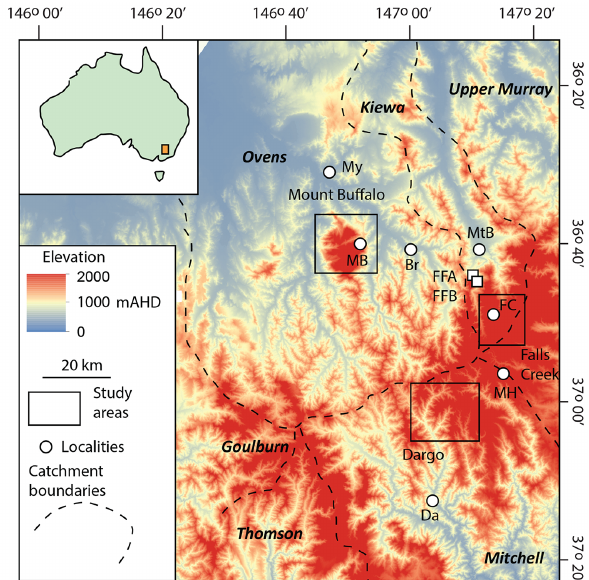
Figure 1. Location of study sites in northeast Victoria superimposed on the digital elevation model. Places: Br indicates Bright; Da indi- cates Dargo; MB indicates Mount Buffalo; MtB indicates Mount Beauty; MH indicates Mount Hotham; My indicates Myrtleford. FFA and FFB are the Falls Forest sampling sites A and B, other sampling sites are in the indicated study areas (see the Supplement Fig. S1). Catchment boundaries from Department of Environment, Land, Water and Planning (2016); elevations are relative to the Aus- tralian Height Datum